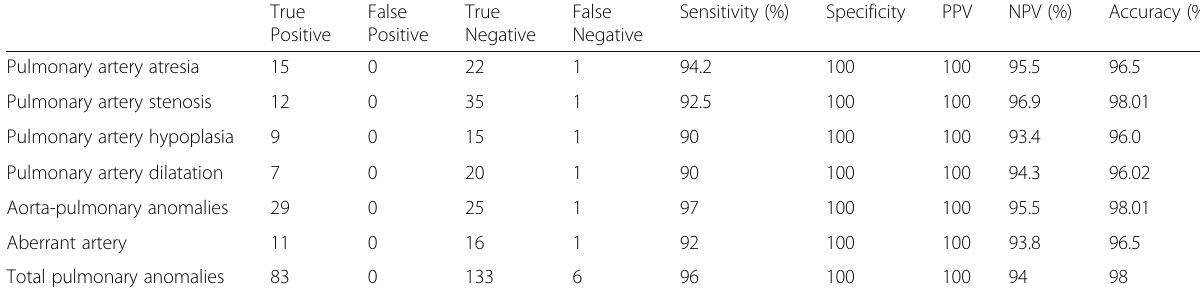
Table 2 Agreement between catheter/operative data and MDCT for pulmonary anomalies